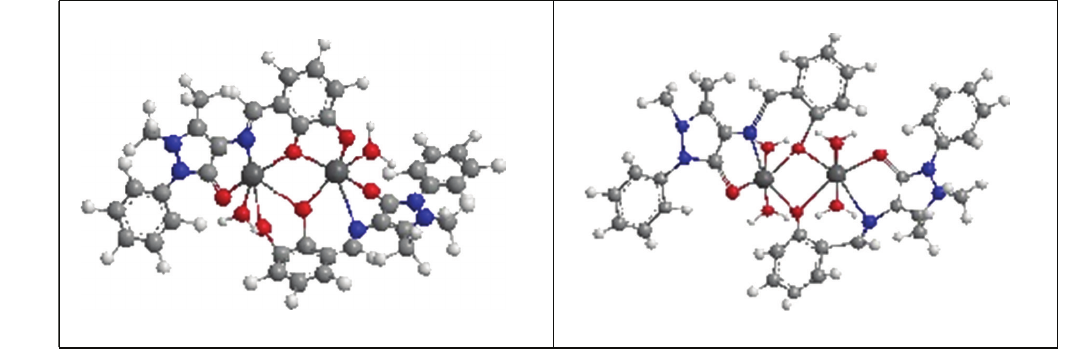
Figure 3: The optimized structural geometry of Cu(II) complexes. Table 3: Structural parameters, bond length ( ◦ A), and angles ( ◦ ) of the [Cu 2 (L2) 2 (H 2 O) 4 ] complex.